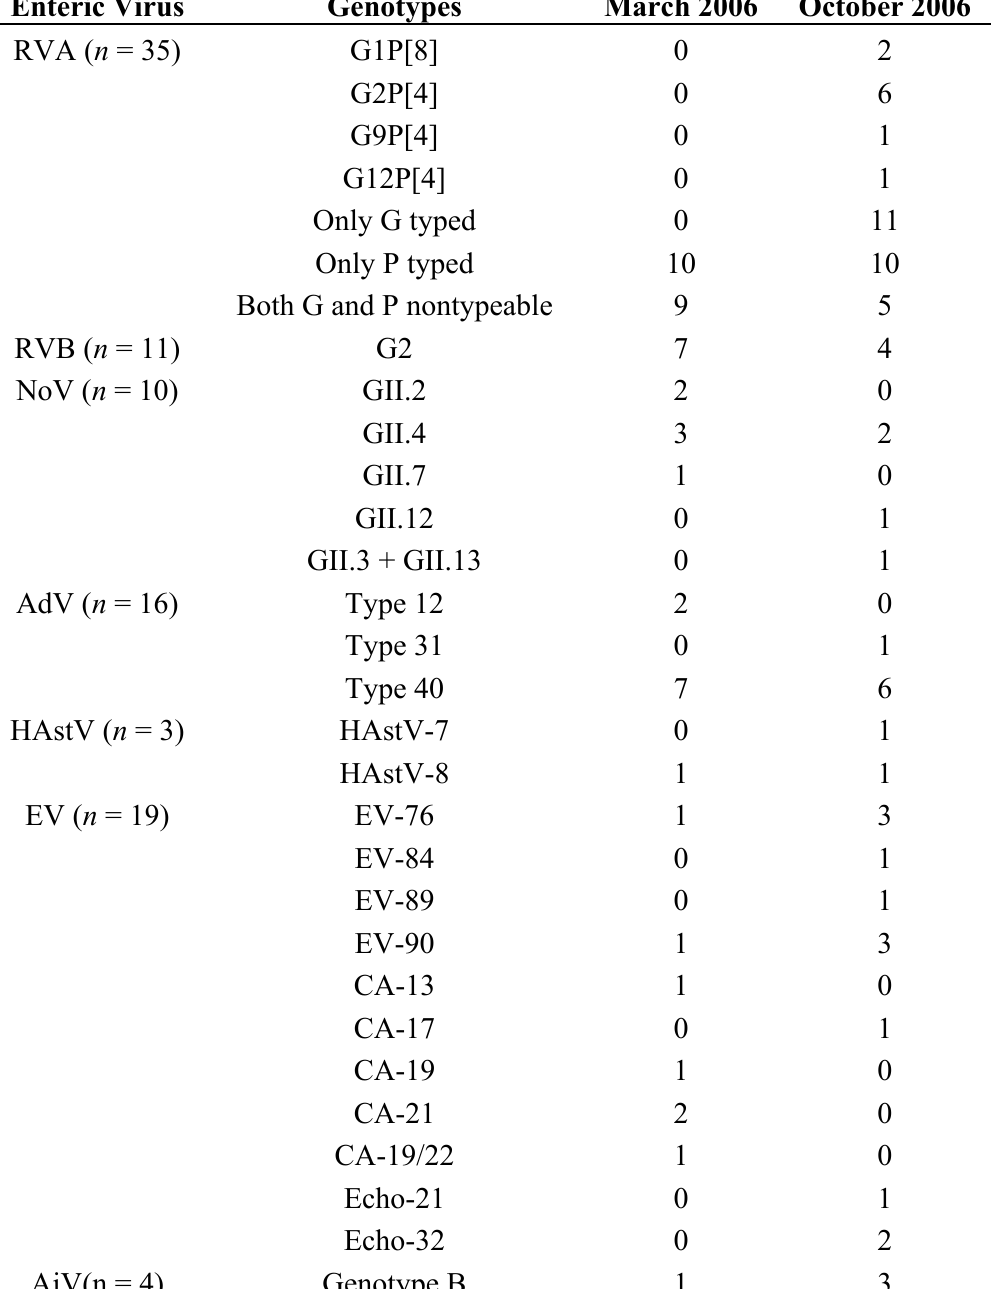
Table 3. Distribution of genotypes of enteric viruses detected in the outbreak cases of